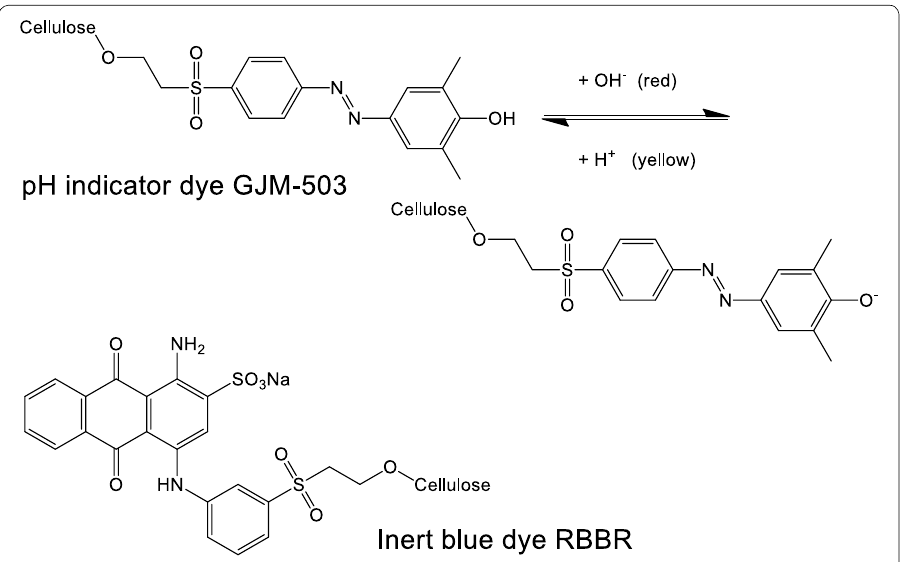
Fig. 1 Chemical structures of the pH indicator dye GJM‑503 and the inert textile dye